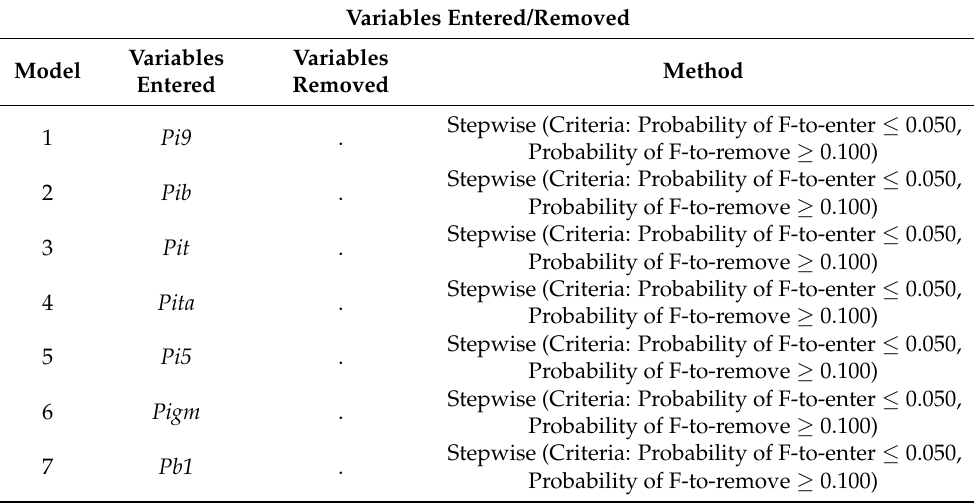
Table 3. Seven variables were entered with multiple stepwise regression.